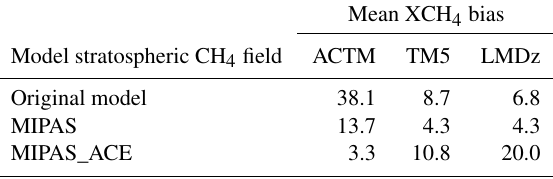
Table 4. Average model XCH 4 bias with respect to TCCON obser- vations in 2010 computed as mean of absolute site-specific biases (see Table 3). Average XCH 4 biases inppb are derived for different model stratospheric CH 4 fields.